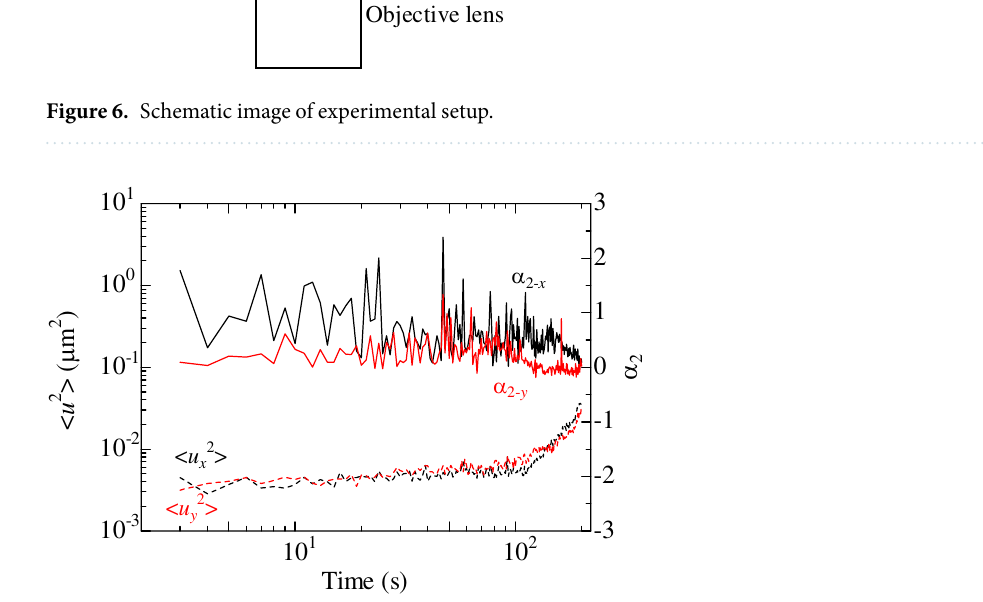
Figure 7. The one-dimensional mean square displacement (dashed lines) and nongaussian parameter (solid